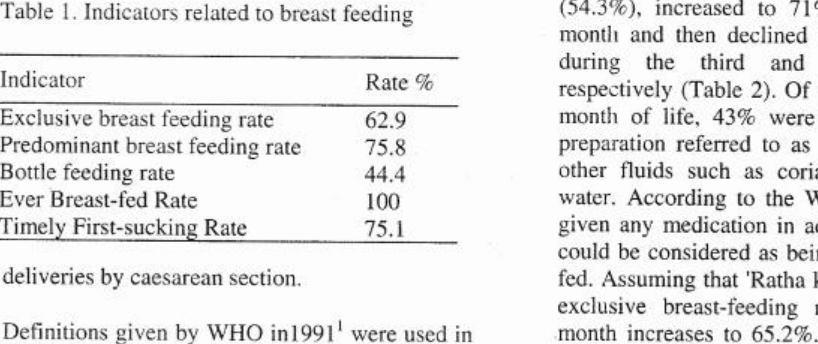
Table 2 Distribution of infants by age a n d by practice of exclusive breast feeding and predominant breast